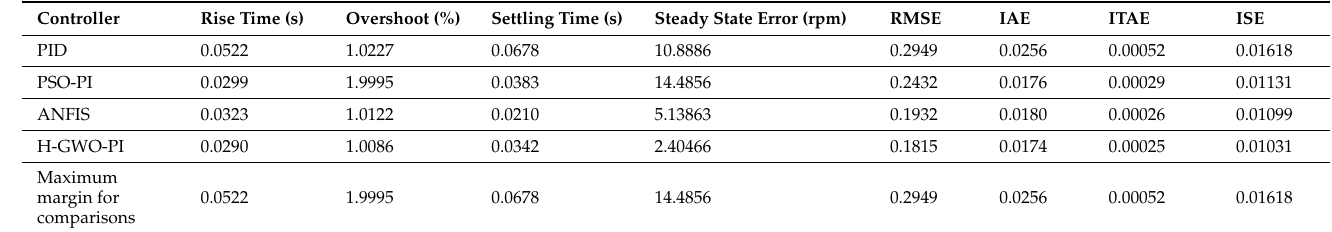
Table 1. No-load condition’s performance parameters.